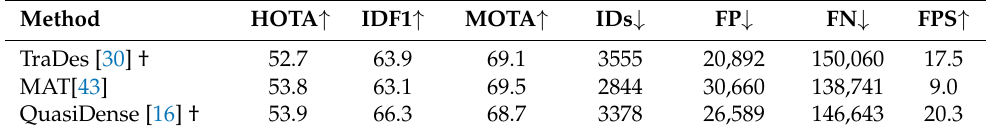
Table 2. Comparison of the state-of-the-art methods under the “private detector” protocol on the MOT17 test set. The best results are shown in bold . MOT17 contains rich scenes and half of the sequences are captured with camera motion. * indicates the addition of linear interpolation and † indicates JDE-based